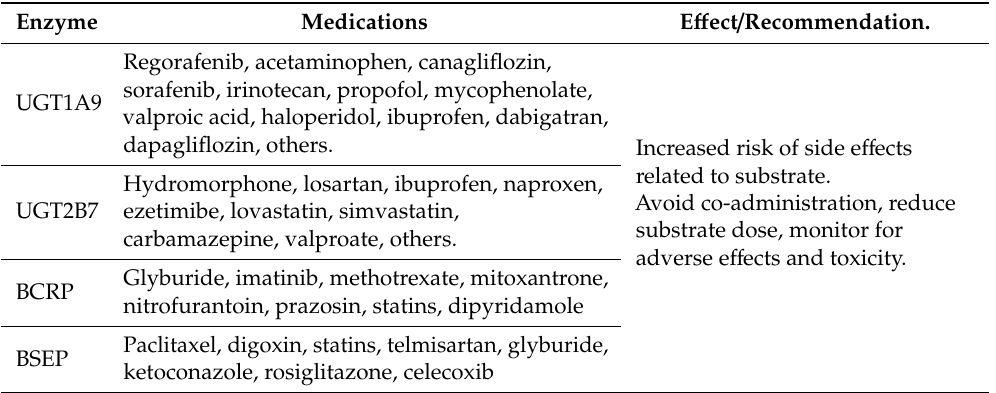
Table 3. Drug–drug interactions between cannabidiol and secondary metabolism or transport proteins. Enzyme Medications E ff ect /